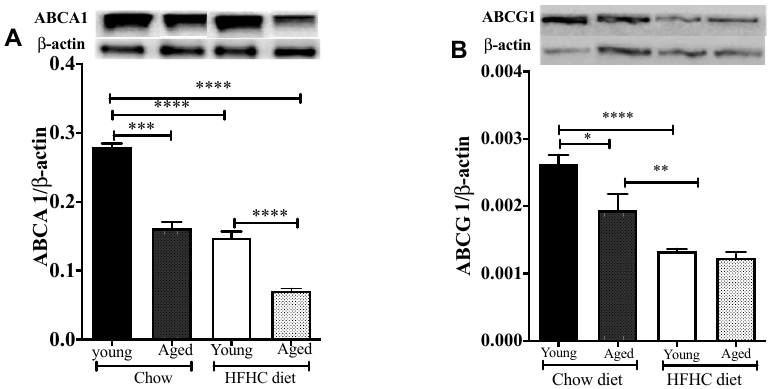
Figure 3. An HFHC diet affects ABCA1/ABCG1 protein expression on peritoneal macrophages. Young and aged mice were fed chow or an HFHC diet for 12 weeks. Peritoneal macrophages were obtained using the thioglycolate method and ( A ) ABCA1 and ( B ) ABCG1 protein expression was analyzed by Western blotting. Data are expressed as means ± SEM * p < 0.0213, ** p < 0.0091, *** p < 0.0003, **** p < 0.0001.